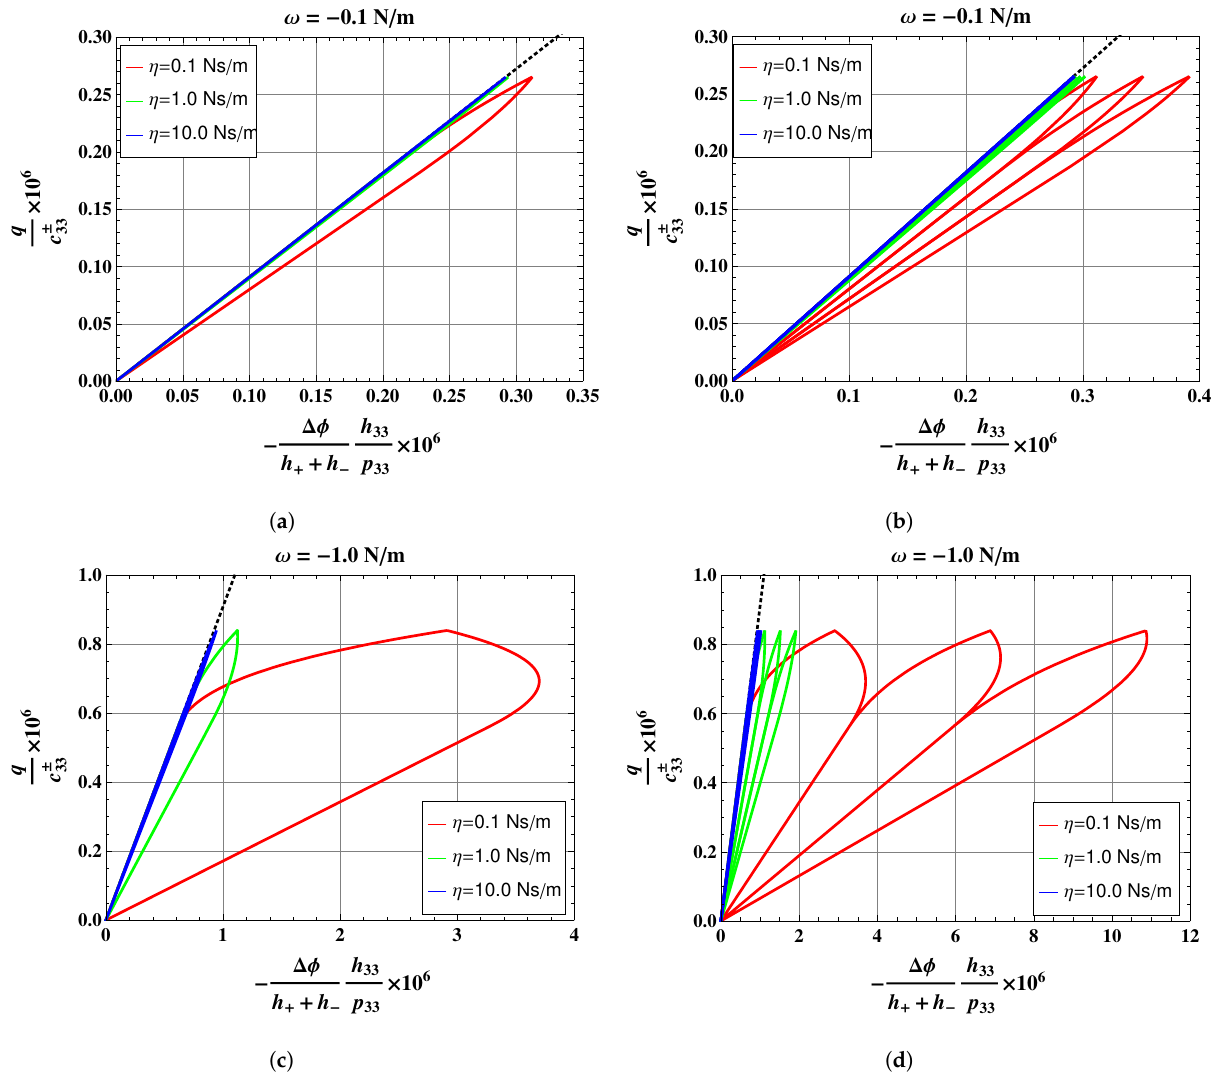
Figure 5. Normalized stress versus normalized potential per unit height in a single loading–unloading cycle ( a , c ) and in multiple loading–unloading cycles ( b , d ) of the layered composite depicted in Figure 2. The different plots show the effect of varying ω and η in in the damage evolution Equation (75). For comparison, normalized stress versus normalized potential per unit height in the purely elastic case is represented with a dotted